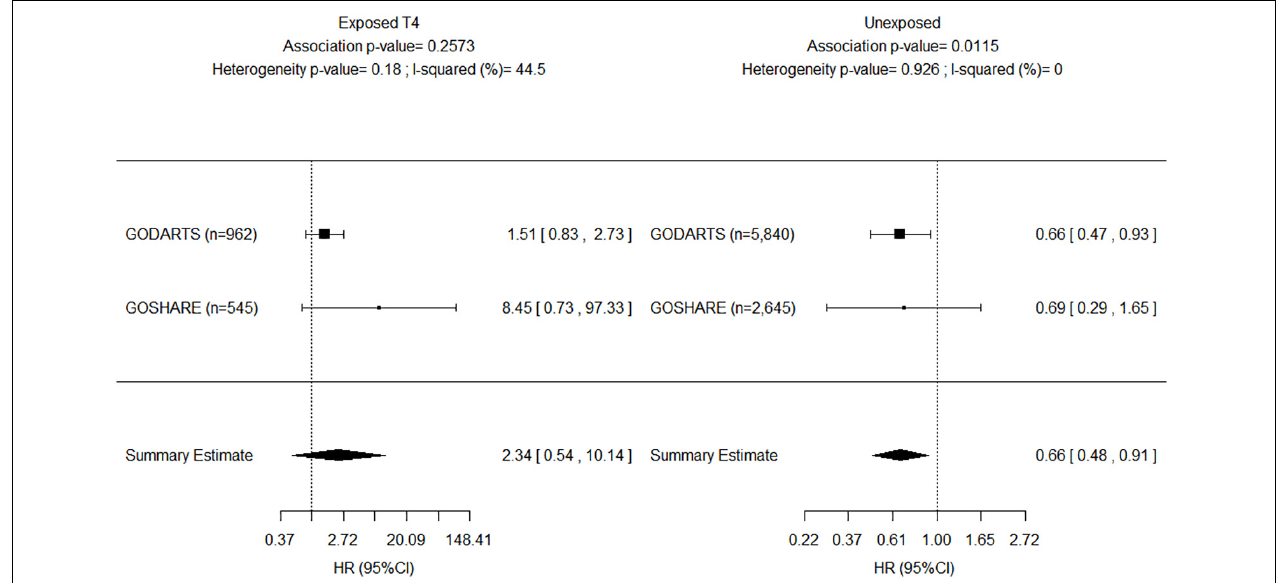
FIGURE 3 | Forest plot for meta-analyses of INSR -rs4804416 on developing atrial fibrillation by exposure to L-thyroxine within 10 years of follow-up. HR, Hazard ratio.